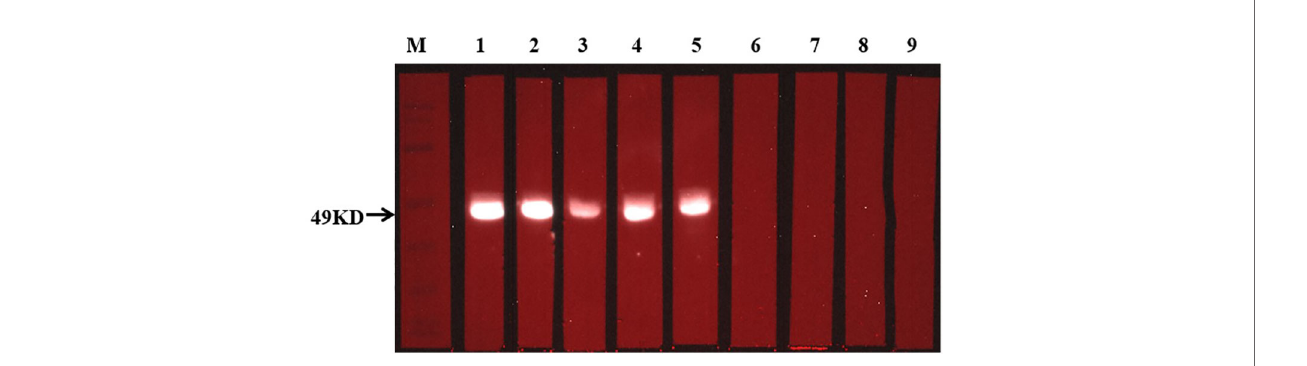
FIGURE 8 | Detection of speci fi c antibody response with Western blotting. The situation of speci fi c antibodies was 49 kDa. In this fi gure, 1-5 from CE group, and 6-9 from HC group.